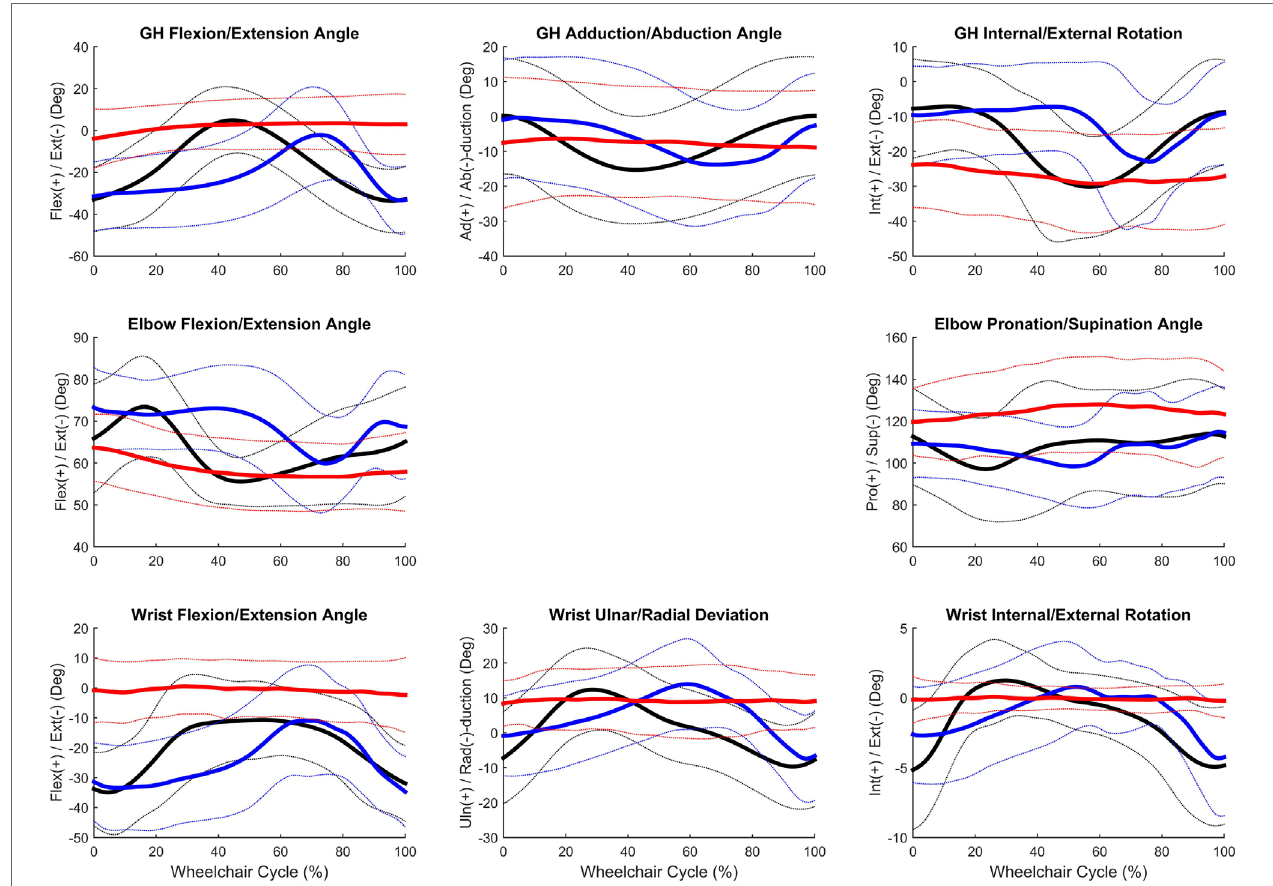
FigUre 4 | group mean (bold) and ± 1 sD for the glenohumeral joint angles (top row), elbow joint angles (middle row), and wrist joint angles (bottom row) during the steady-state propulsion (black), start stroke (blue), and stopping stroke (red)